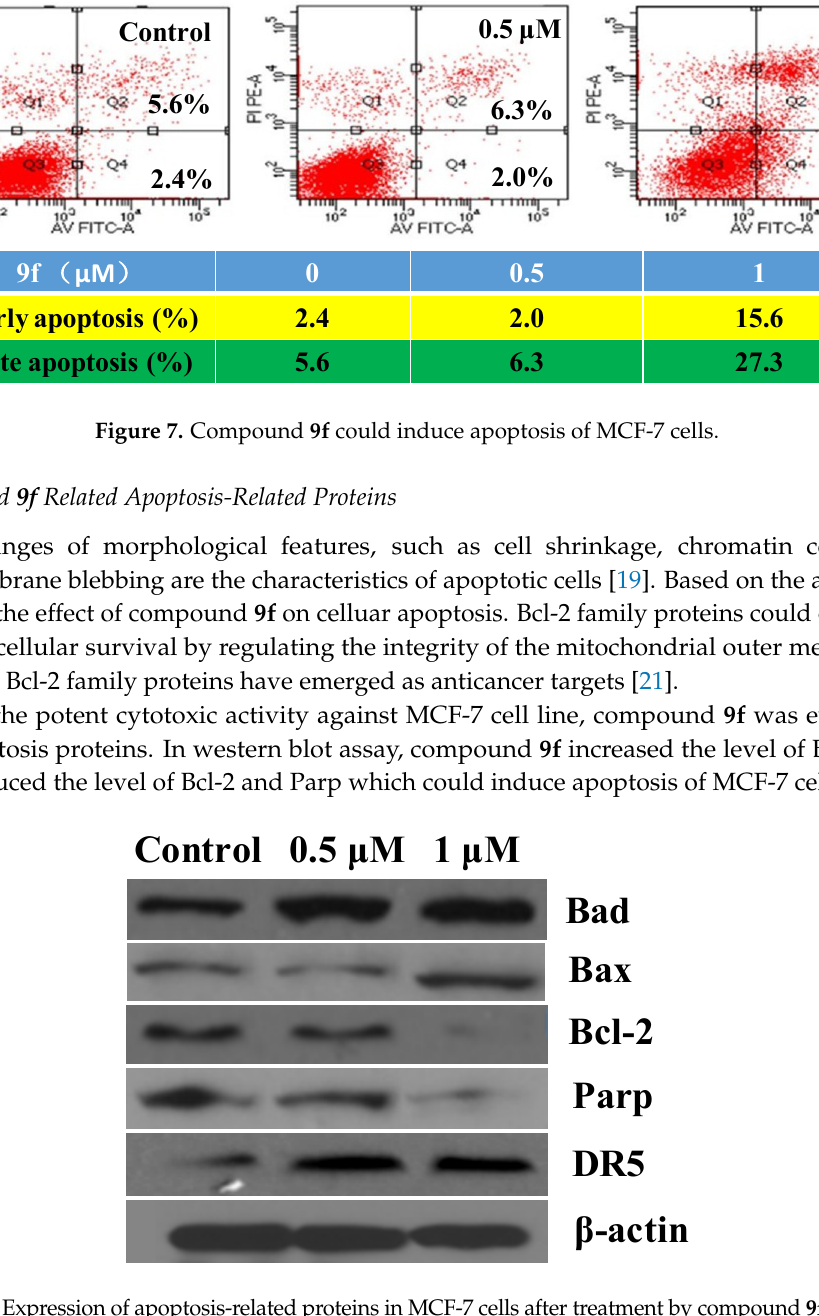
Figure 8. Expression of apoptosis-related proteins in MCF-7 cells after treatment by compound 9f for 24 h.